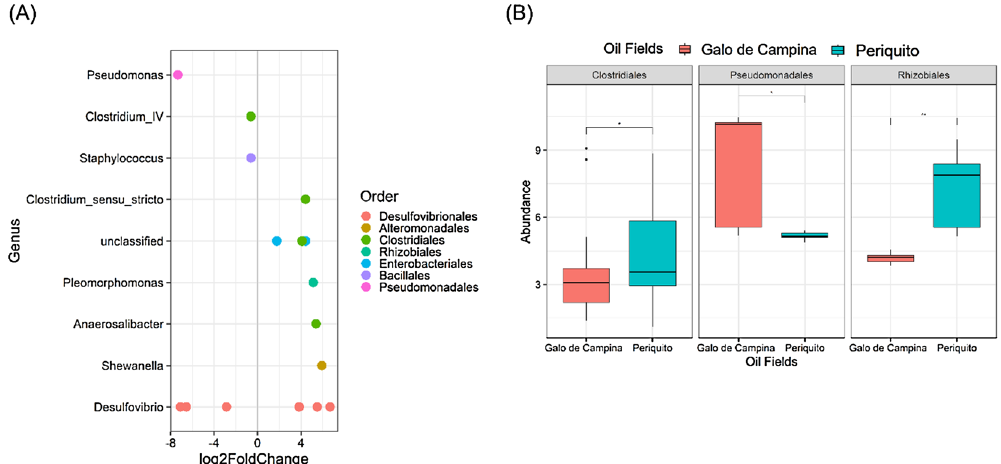
Figure 4. Differential abundance of OTUs between oil fields using DESeq2. ( A ) Bar plot showing the log2foldchange of abundance at the Order and Genus level. ( B ) OTUs that presented abundances with significant variations (adjusted p-value < 0.05) with respect to oil